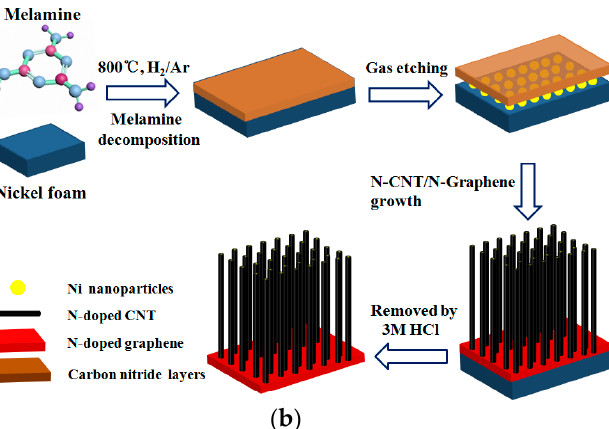
Figure 1. ( a ) Illustration of the main synthetic device of N-CNTs/N-graphene hybrid; ( b ) Schematic diagram of the of N-CNTs/N-graphene material synthesized by one-step CVD method.